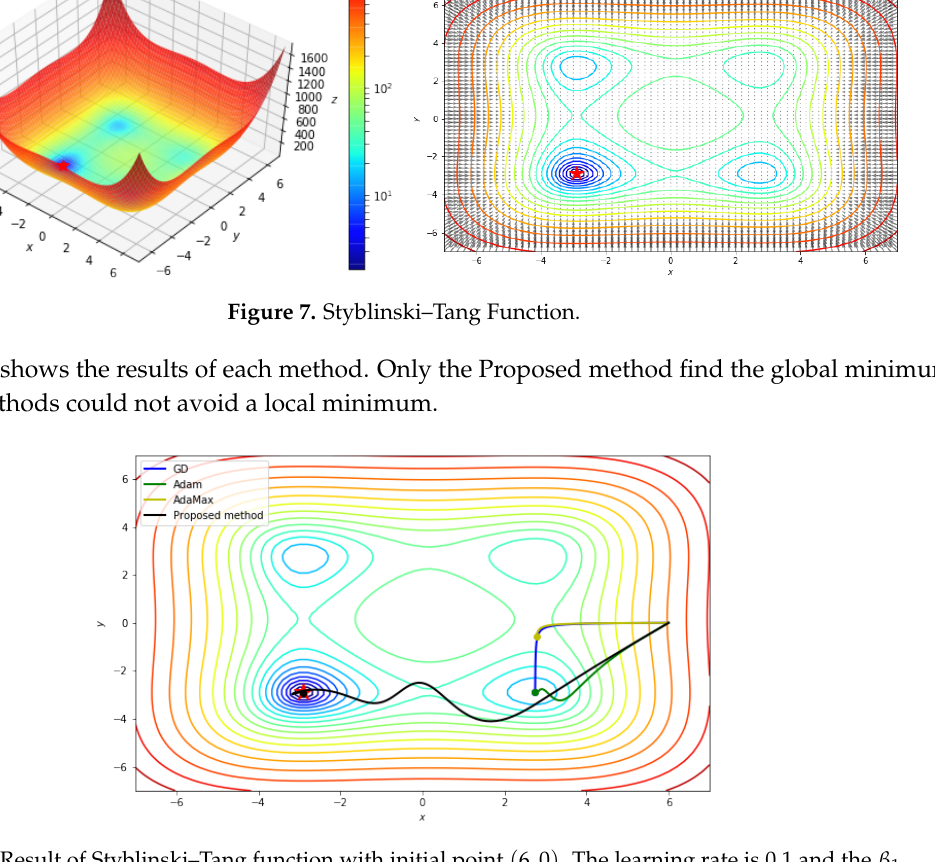
Figure 8. Result of Styblinski–Tang function with initial point ( 6,0 ) . The learning rate is 0.1 and the β 1 , β 2 , λ used in Proposed method are 0.95, 0.9999, 0.2 and GD’s learning late was set to 10 − 3